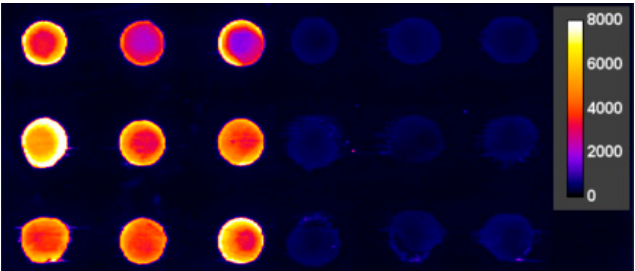
Figure 3. Comparison of different surface coatings for antibody immobilization. In this experiment, fluorophore-labeled goat IgG was incubated on spots of immobilized Cys-Protein-G ( left ) and protein G ( right ). The spot to spot distance is 1 mm in the x - and y -dimension.